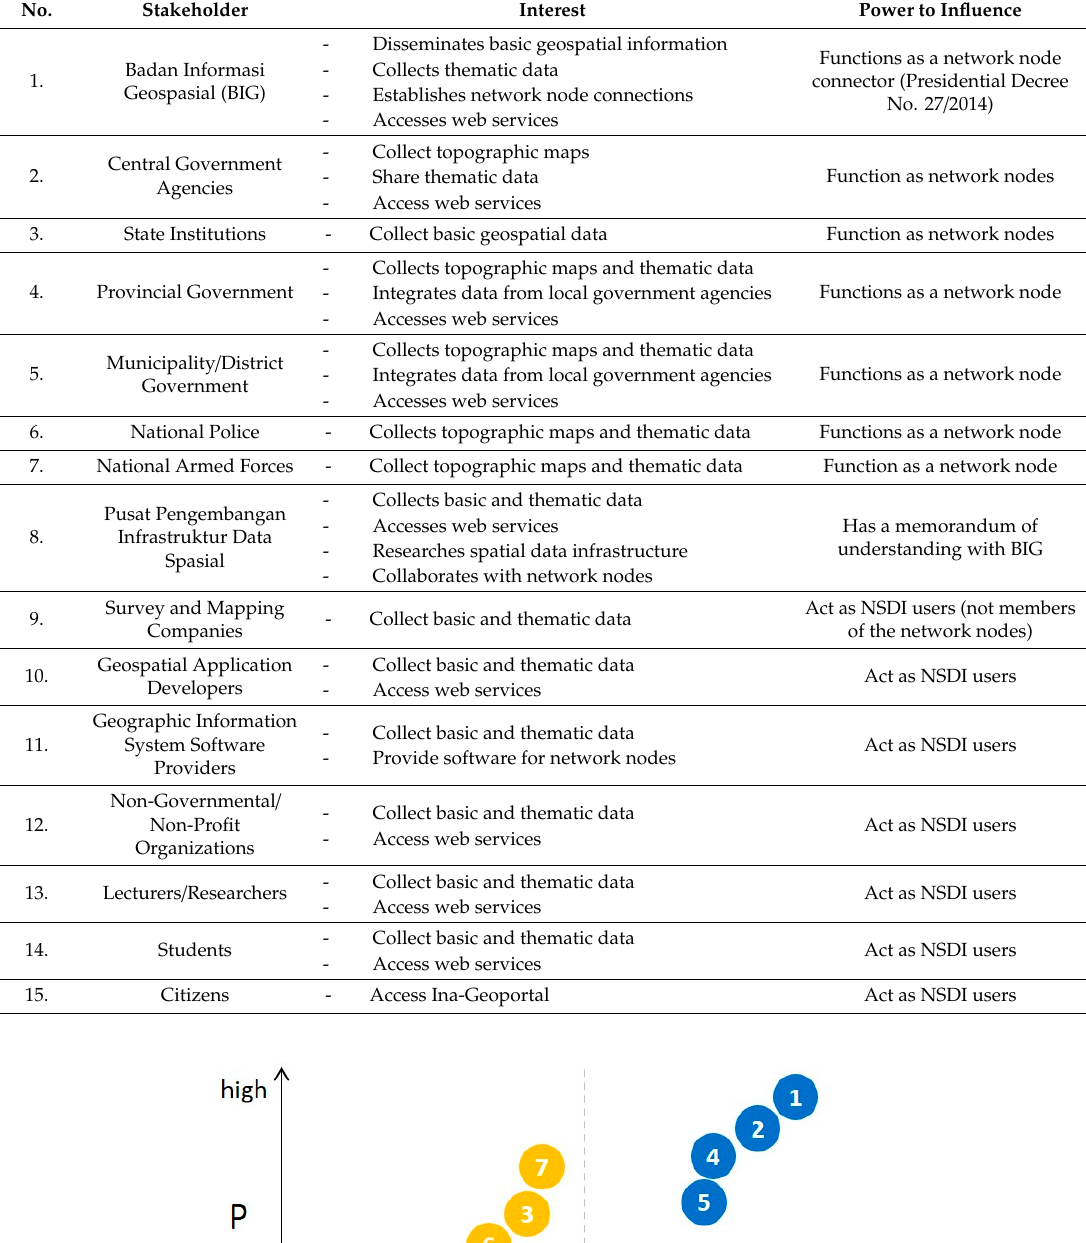
Table 2. Interest and power of stakeholders of the national spatial data infrastructure (NSDI).